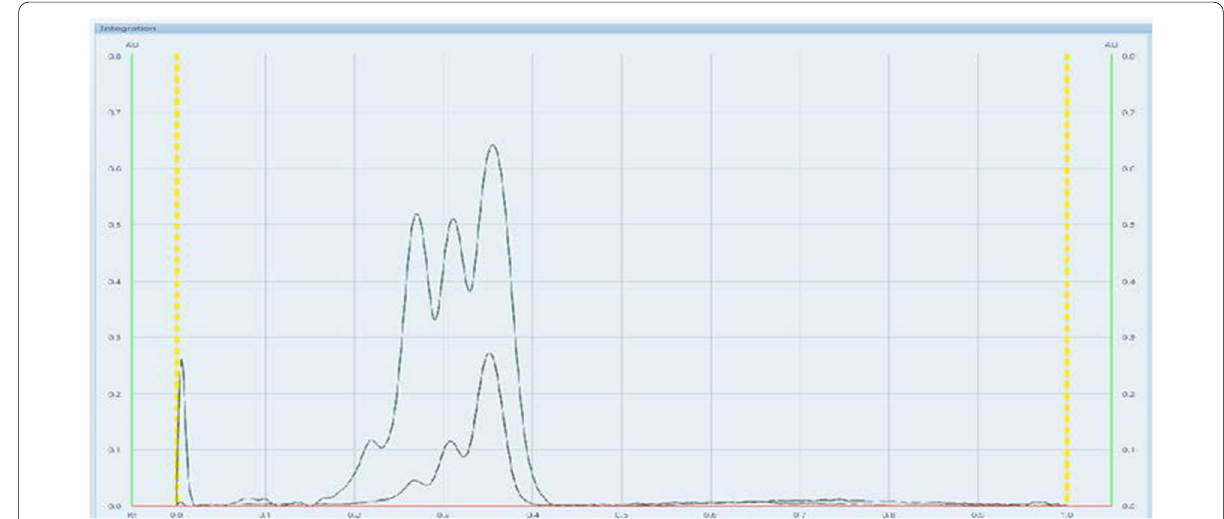
Fig. 3 UV spectrum of curcumin